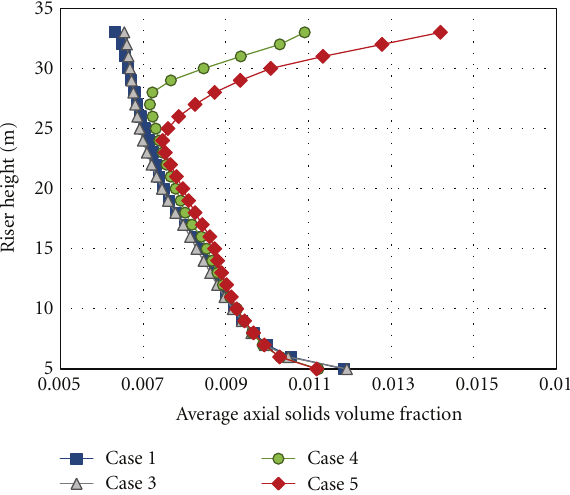
Figure 10: Average solids volume fraction in cross-section planes along the